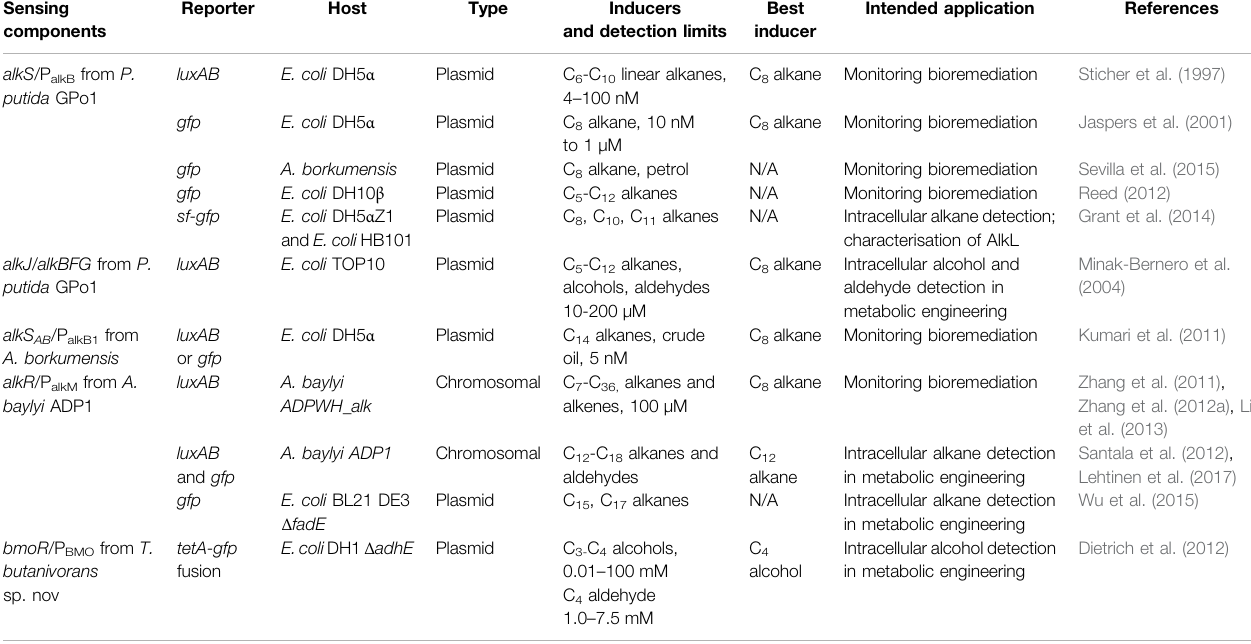
TABLE 6 | Compilation of existing hydrocarbon